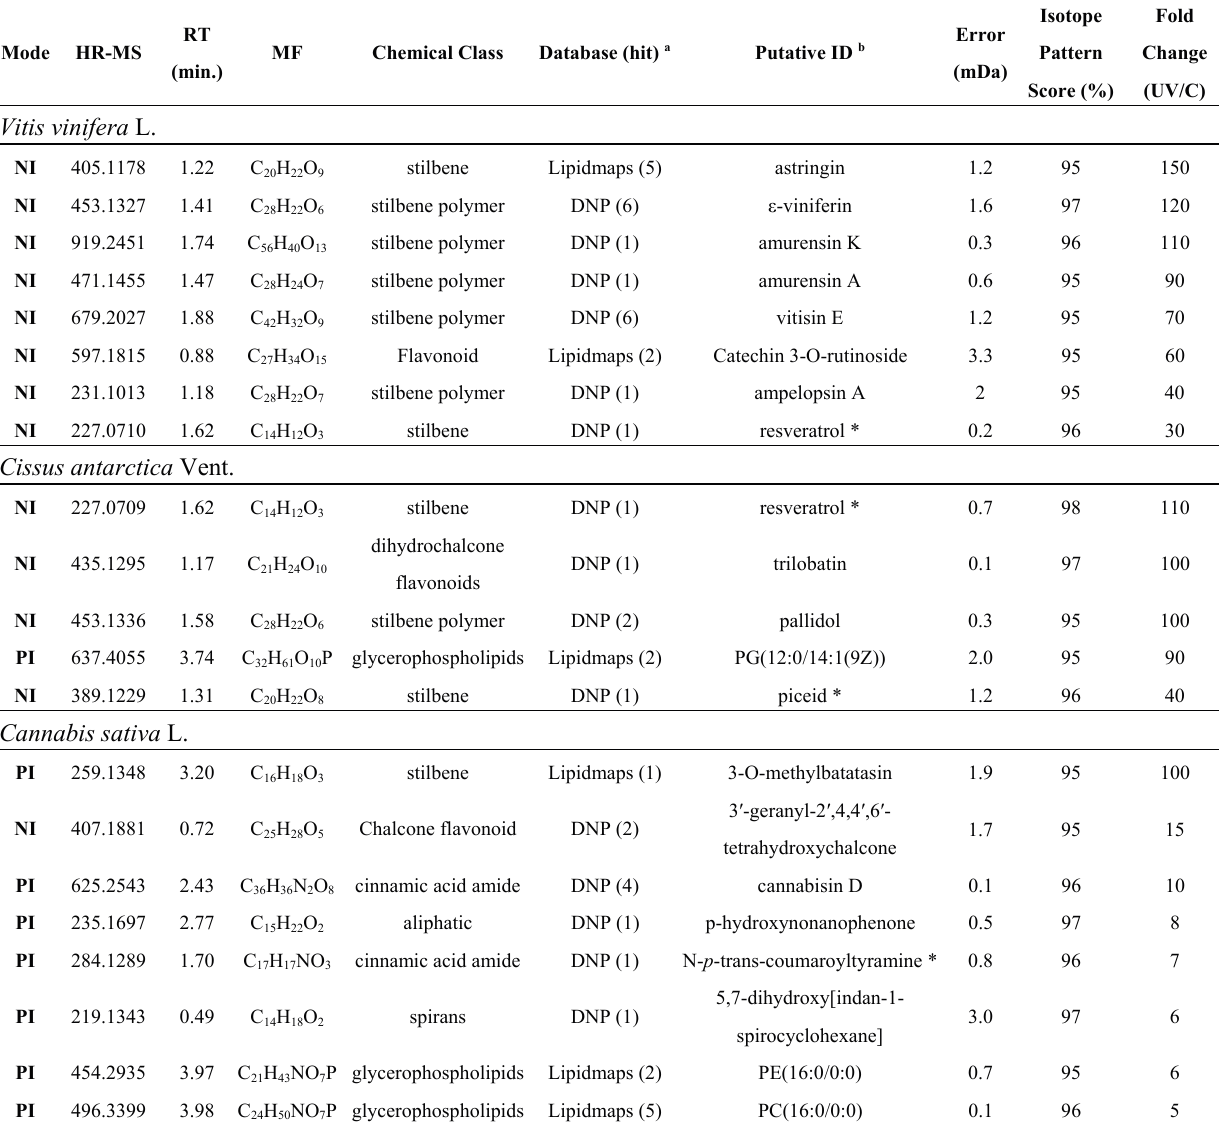
a For the DNP database, the molecular formula was crossed-filtered using the genus name or family name. The number of hits is indicated in brackets; b In the case of more than one hit, the annotation is indicative of a compound characteristic of the class; * Comparison with pure standard. The fold change indicates the ratio of intensity (up-regulation) of a given feature in the UV-C leaves compared to